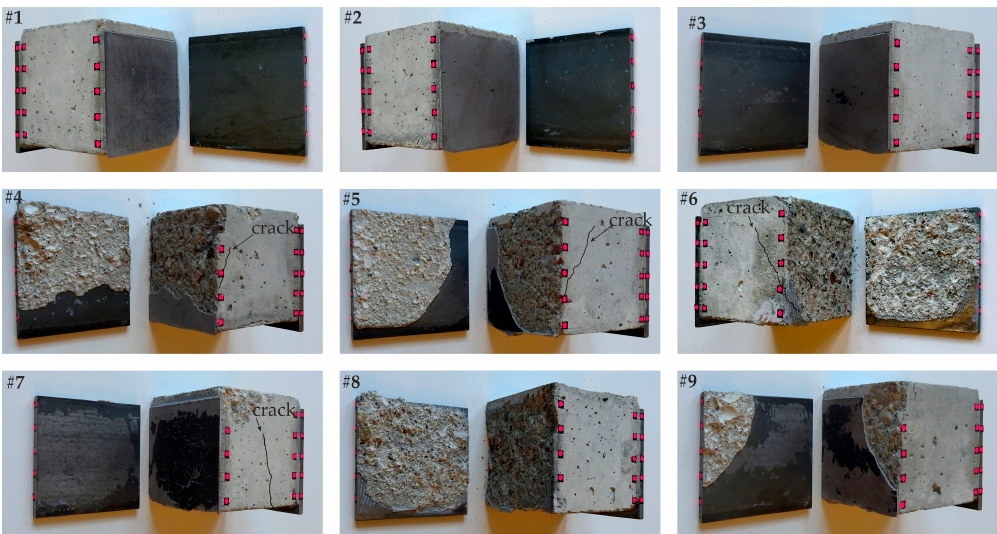
Figure 7. Failure modes of tested steel-concrete specimens (photographs of the damaged steel- concrete interface after removing from the testing machine): mode I including specimens #1 to #3 — adhesive failure and mode II including specimens #4 to #10 —cohesive-type failure or mixed cohesive- adhesive failure.